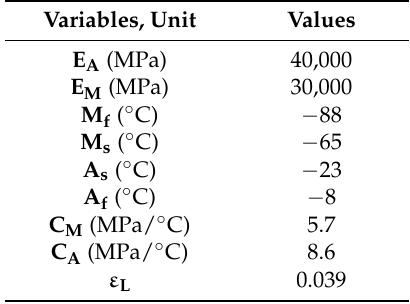
Table 4. Material properties of the NiTi wires purchased from Fort Wayne Metals Ltd. (Fort Wayne, IN,